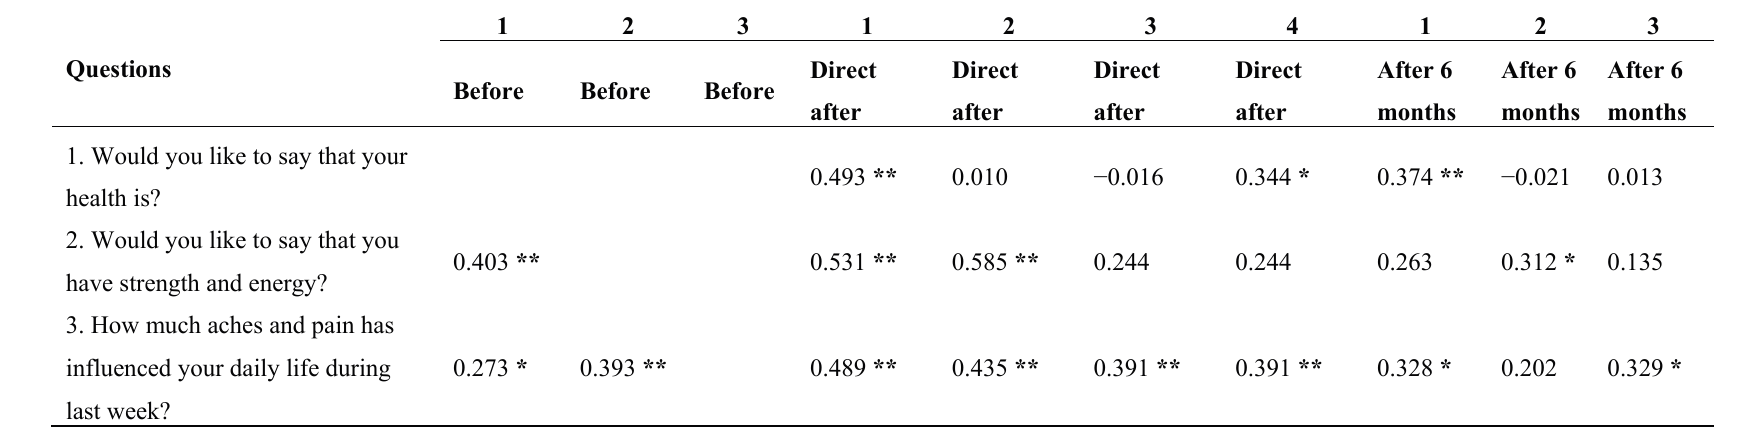
Table 5. Correlations between questions asked during three measurements (Spearman) ( n =